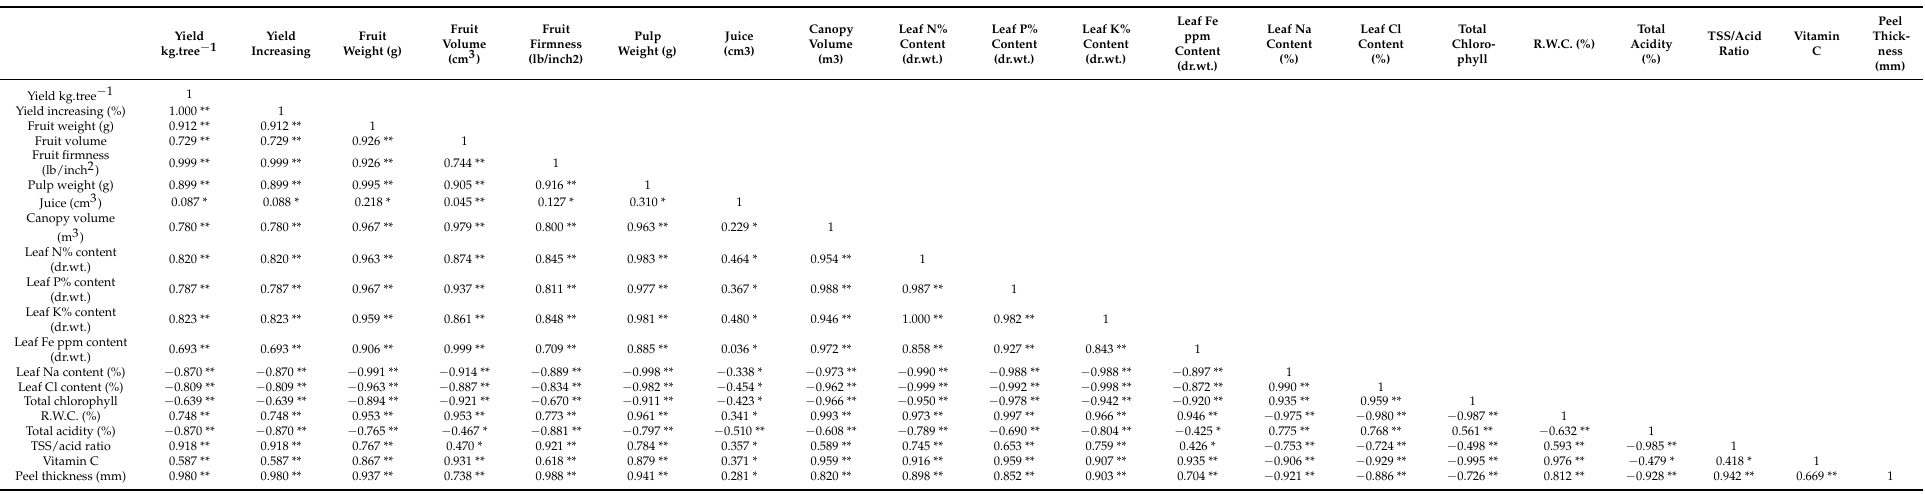
Table 2. Correlation analysis of the measured parameters of the effect of magnetic iron application on the fruit physic chemical properties of ‘Chinese’ mandarin trees during